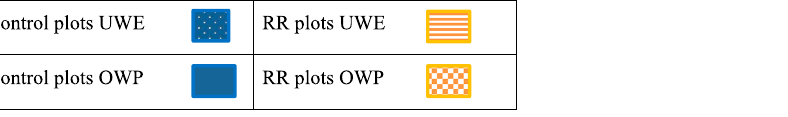
Frontiers in Environmental Science |